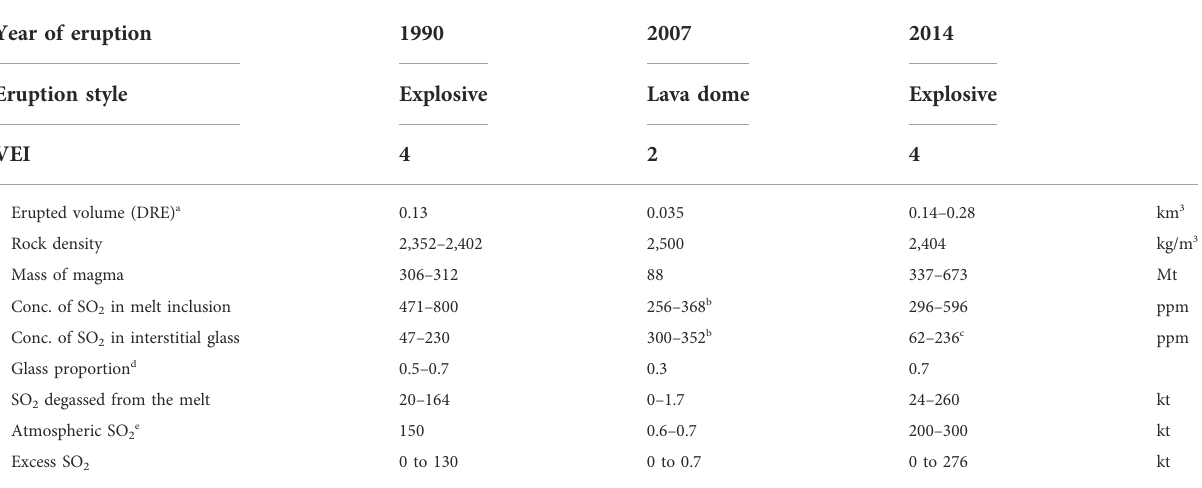
TABLE 6 Mass balance calculation of SO 2 exsolved from the melt and measured by